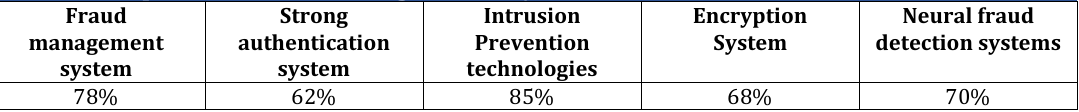
Table 13: Response about Technologies Used by Banks to Detect and Prevent Frauds Fraud